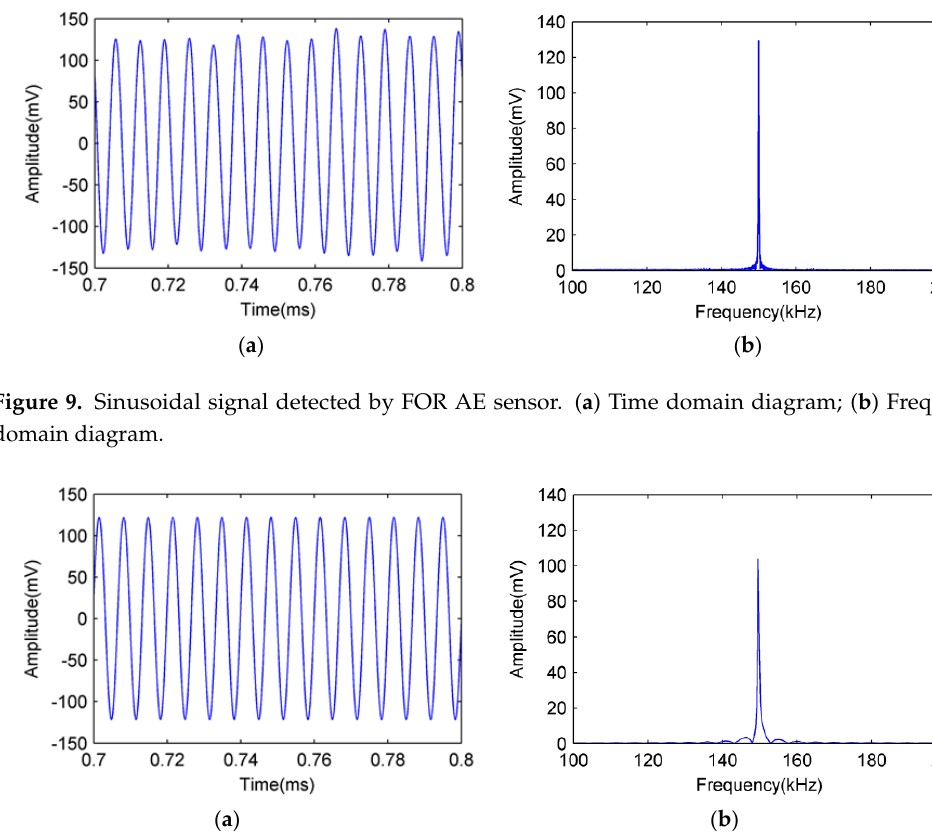
Figure 10. Sinusoidal signal detected by PZT R15 sensor. ( a ) Time domain diagram; ( b ) Frequency domain diagram.